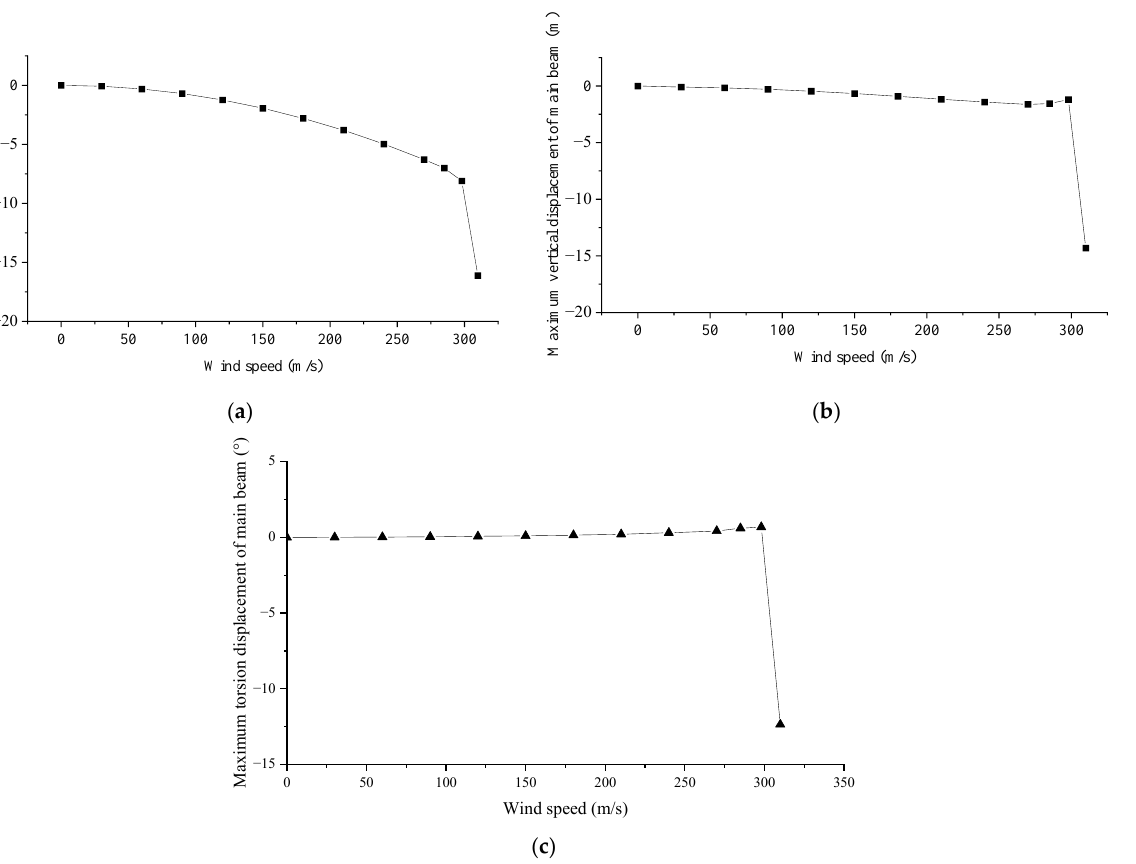
Figure 9. Variation curves of the maximum displacement of the main beam with wind speed. ( a ) Transverse displacement; ( b ) Vertical displacement; ( c ) Torsion angle.